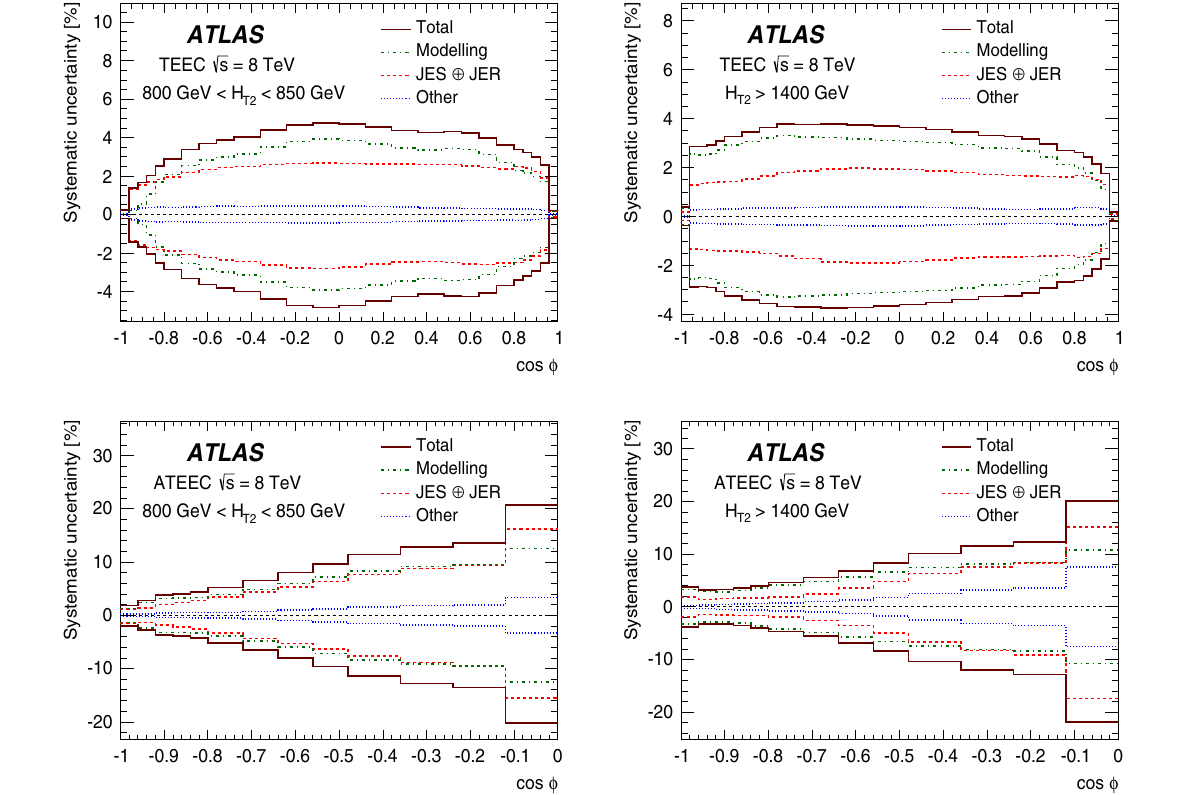
Fig. 2 Systematic uncertainties in the measured TEEC (top) and ATEEC distributions (bottom) for the first and the last bins in H T2 . The total uncertainty is below 5% in all bins of the TEEC